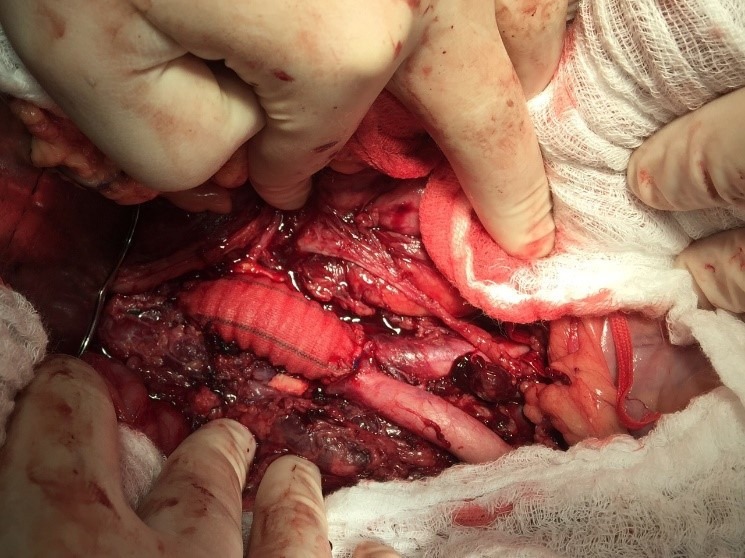
Final result after interposition of the dacron graft.